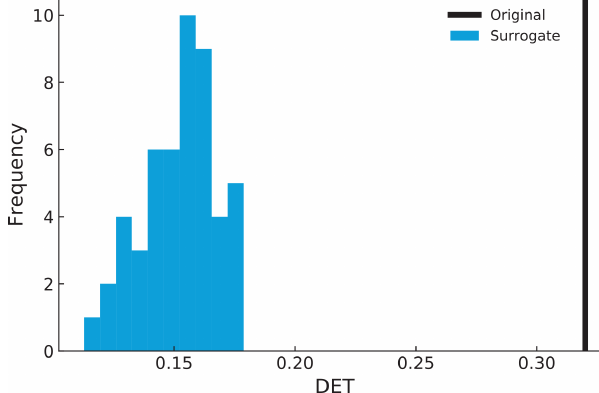
Figure 15. Comparison of DET for flood events using ED (horizon- tal line) and using mED (curved line) for 6 months of overlapping (in blue color) and for 9 months of overlapping (in red color).